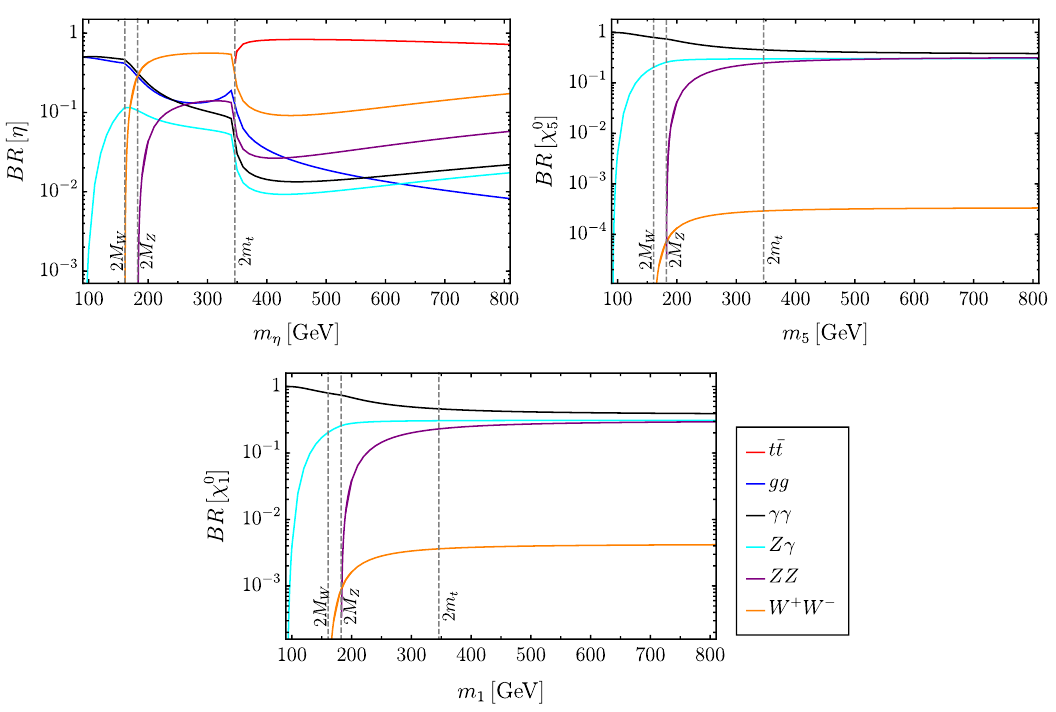
Figure 6 . Branching ratios of pseudoscalar pNGBs into SM final states using the values of M , f , y L,R and κ given in table 4 and dim( ψ ) = 6 in the anomalous couplings of eq. (2.7). We assume that mass splitting among the pNGBs remain same as given in table 4 throughout the entire mass range on the horizontal axes of each